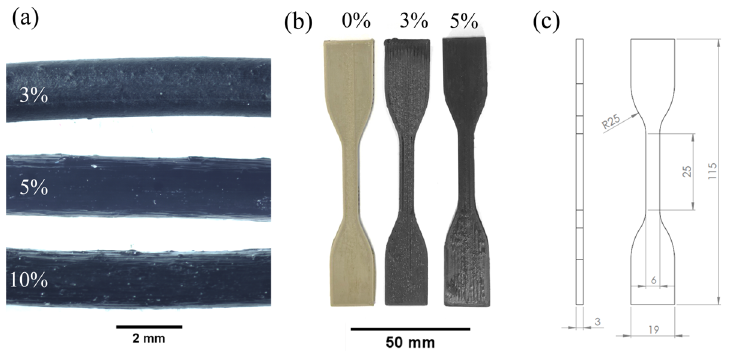
Figure 1. ( a ) Extruded filaments; ( b ) 3D-printed samples; ( c ) tensile specimen